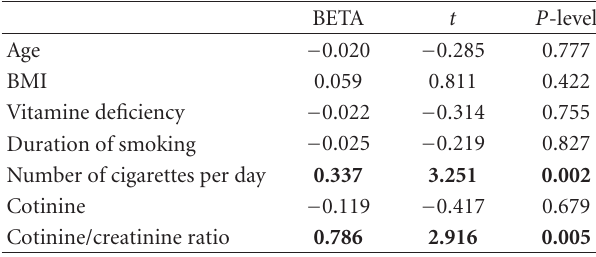
Table 5: Multiple regression analysis of di ff erent